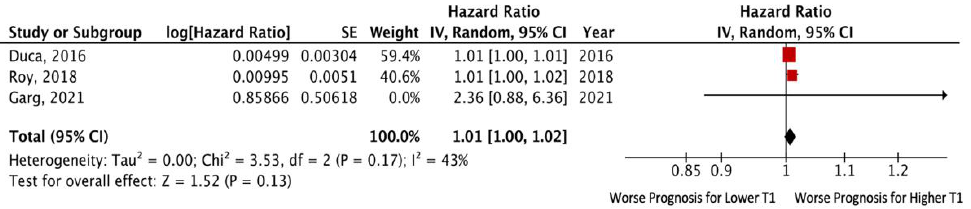
Figure 4. Forest plots comparing outcomes with lower and higher T1 in HFpEF patients.